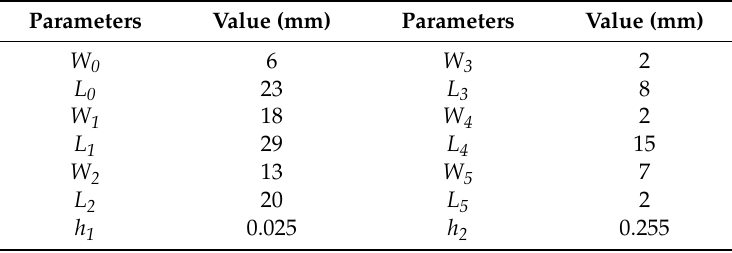
Table 2. The optimized parameters of the